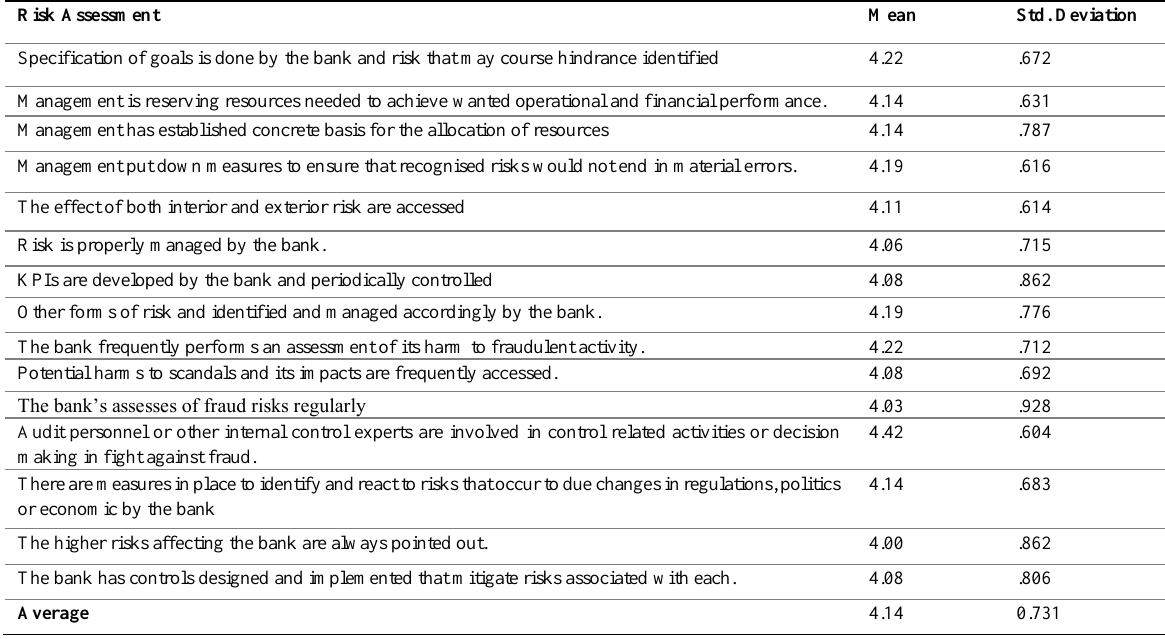
Table 5: Means, standard deviation for Risk Assessment Component of